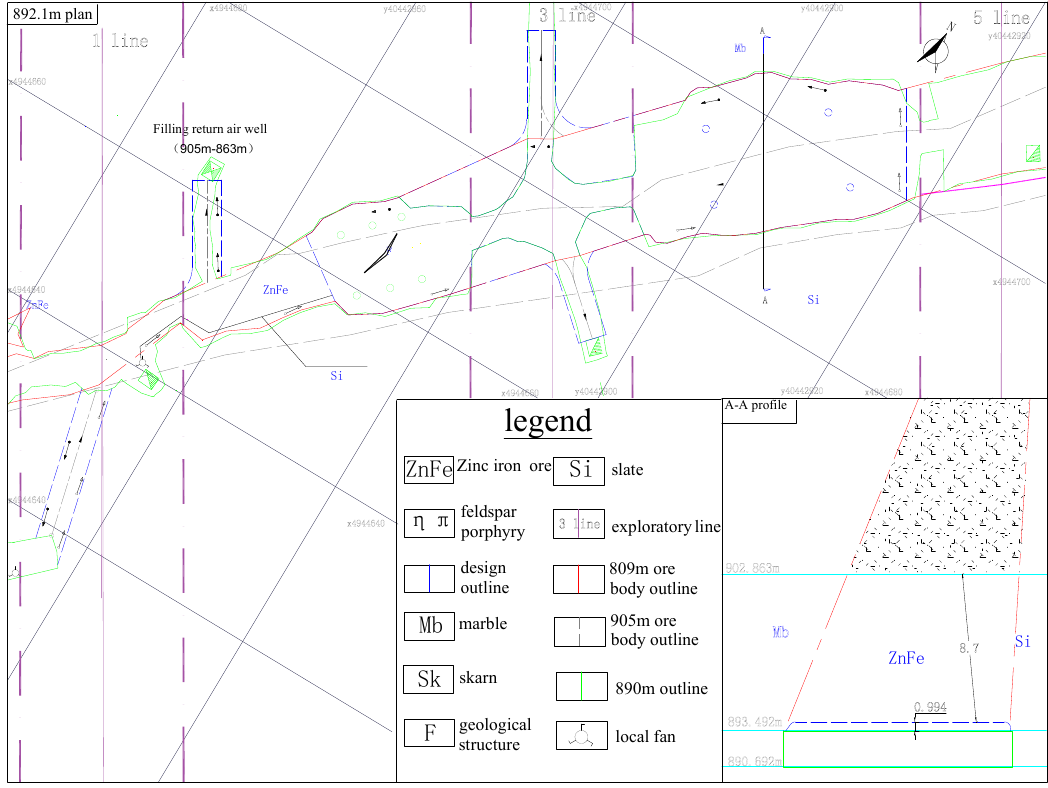
Figure 2. Plan of Lines 1–3 of 890 horizontal in 855 m middle sublevel.